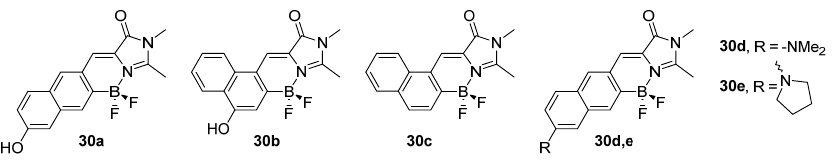
Figure 28. GFPc analogues with a more conjugated backbone [46].